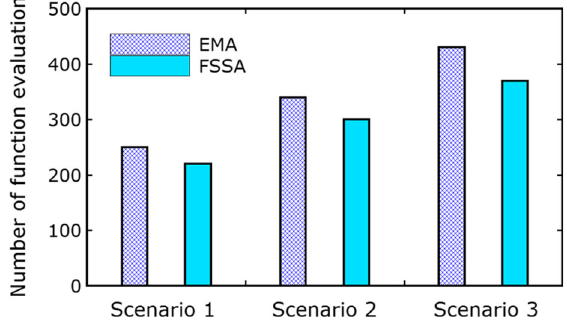
Fig. 11 Comparison of function evaluation adopted by various